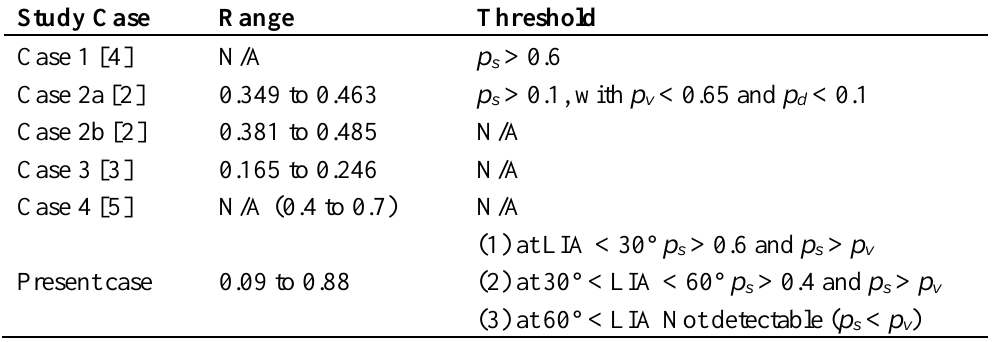
Table 5. The ranges of the p s value in landslides and the proposed thresholds for landslide